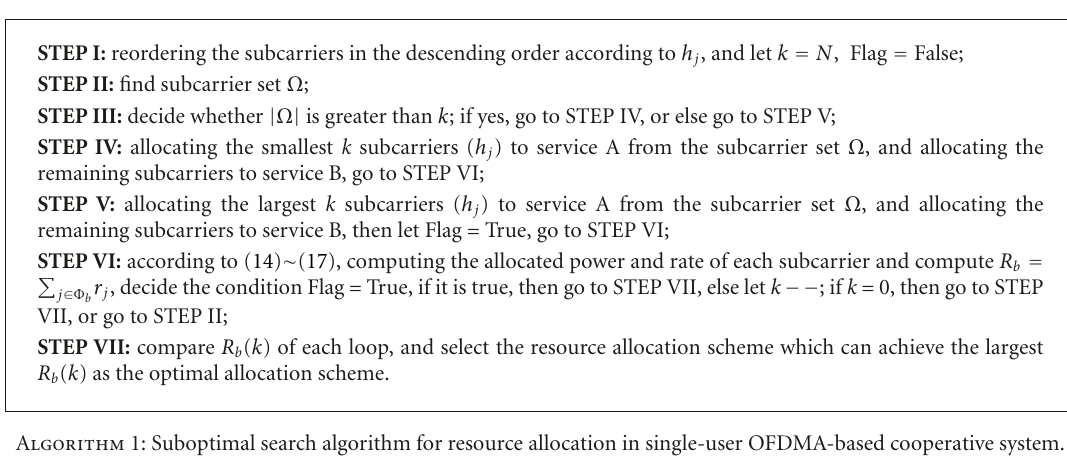
Algorithm 1: Suboptimal search algorithm for resource allocation in single-user OFDMA-based cooperative